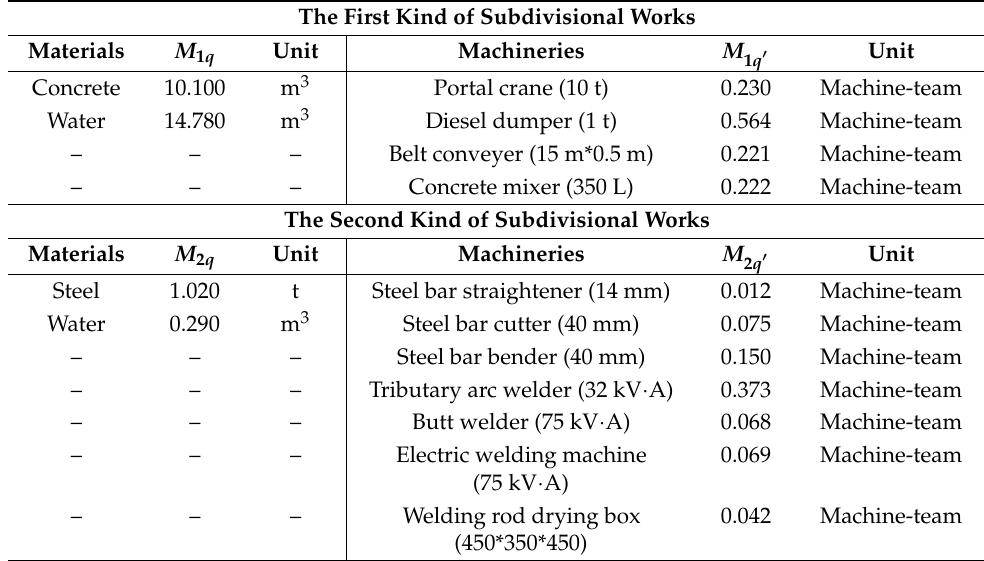
Table 8. The Material and Machinery Consumption of the First and Second Kinds of Subdivi- sional